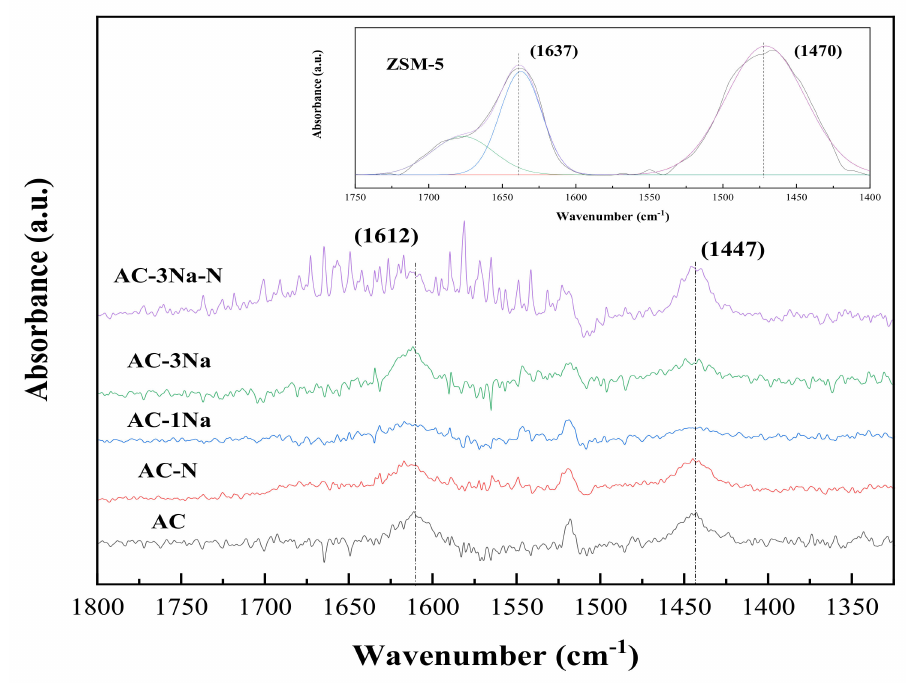
Figure 5. In situ NH 3 -desorption FT-IR spectra of ACs and ZSM-5